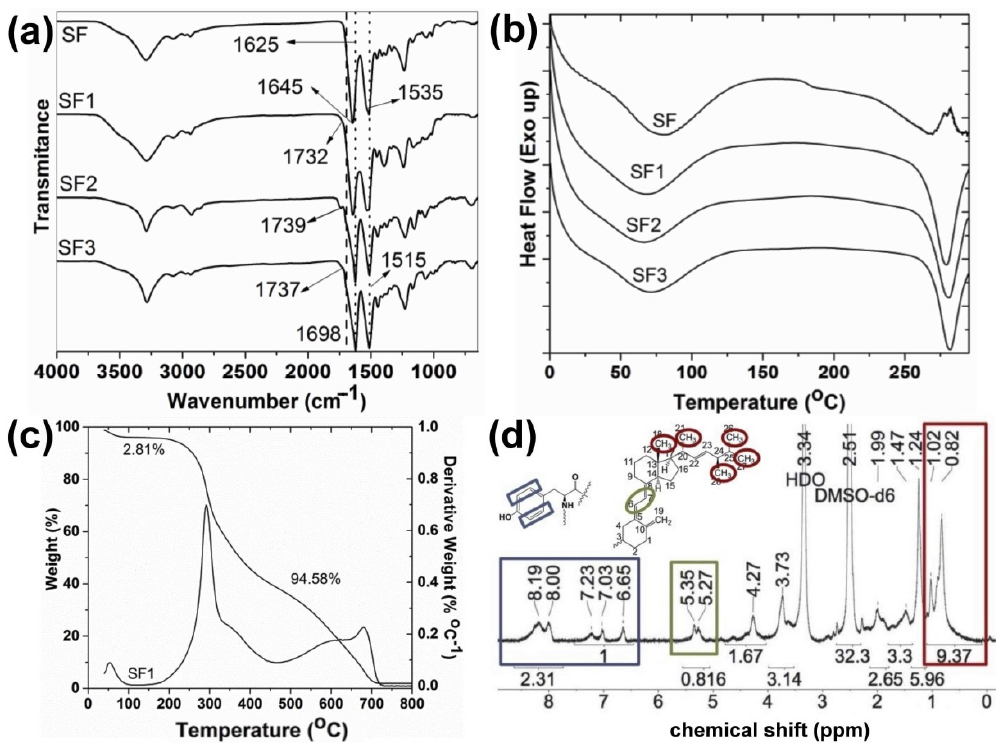
Figure 2. ( a ) IR spectra of native and modified SF; ( b ) DSC curves of SF and SF1–SF3 conjugates; ( c ) TGA thermogram of SF1 with weight loss indicated; ( d ) 1 H NMR spectrum of SF1 in DMSO-d 6 (see structures in Figure 1).